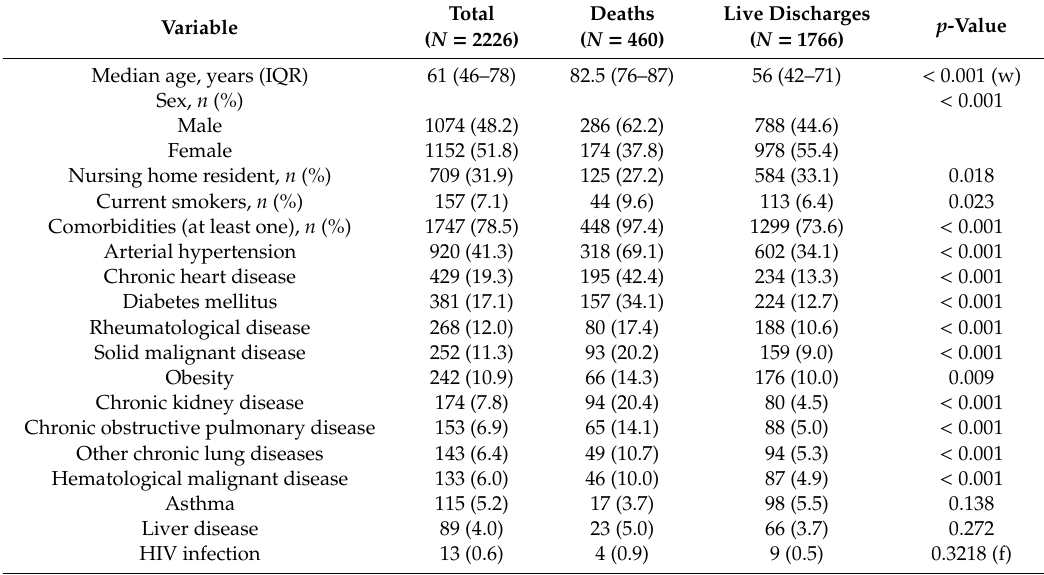
Table 1. Characteristics at admission and complications during hospitalization. 151